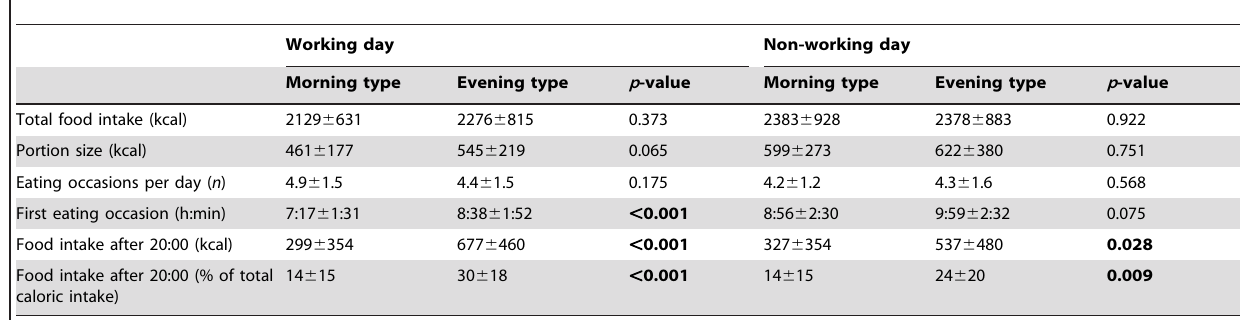
Table 3. Food intake parameters of study participants divided by chronotype on working vs. non-working days.